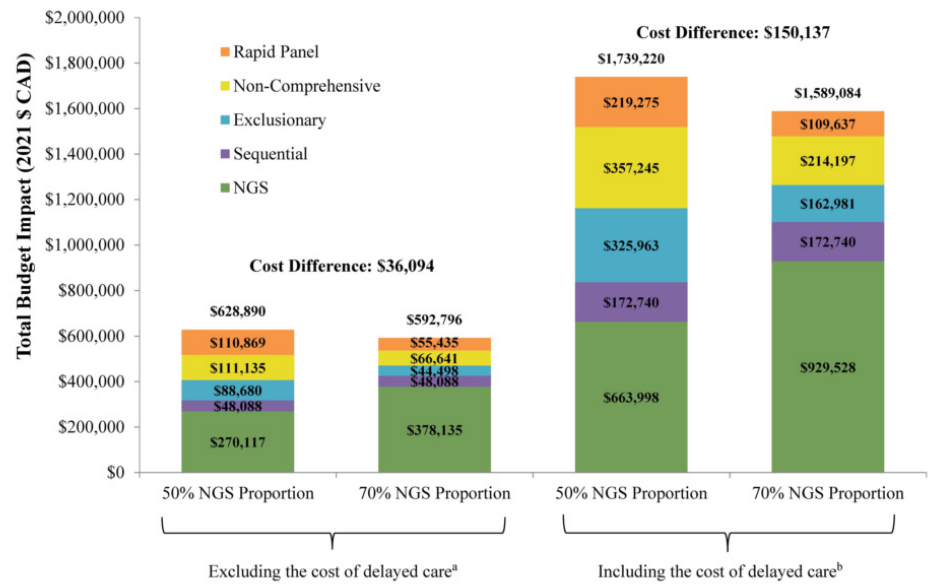
Figure 2. Total budget impact of increasing the proportion of patients tested with NGS from 50% to